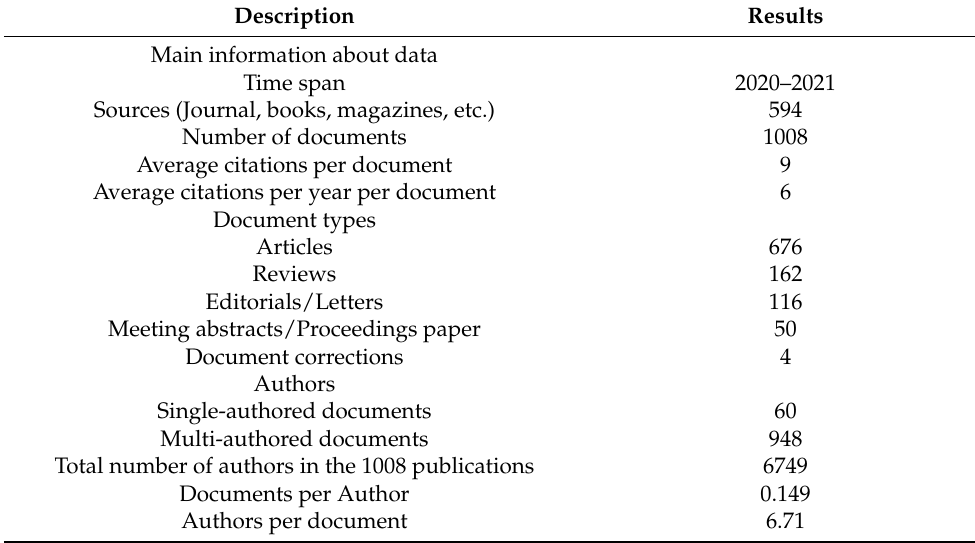
Table 1. Main characteristics of the included UAE-affiliated publications.